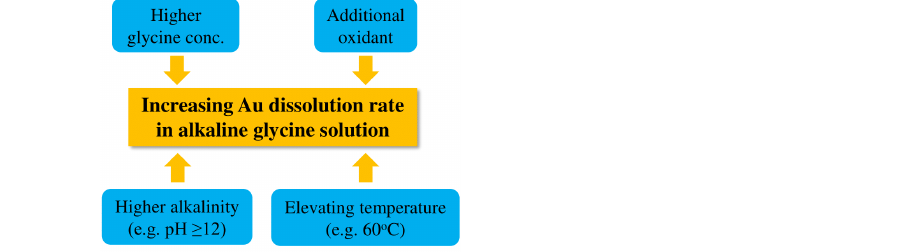
Figure 2. Options to increase gold dissolution rate in alkaline glycine solutions (summarized from [12–14]).